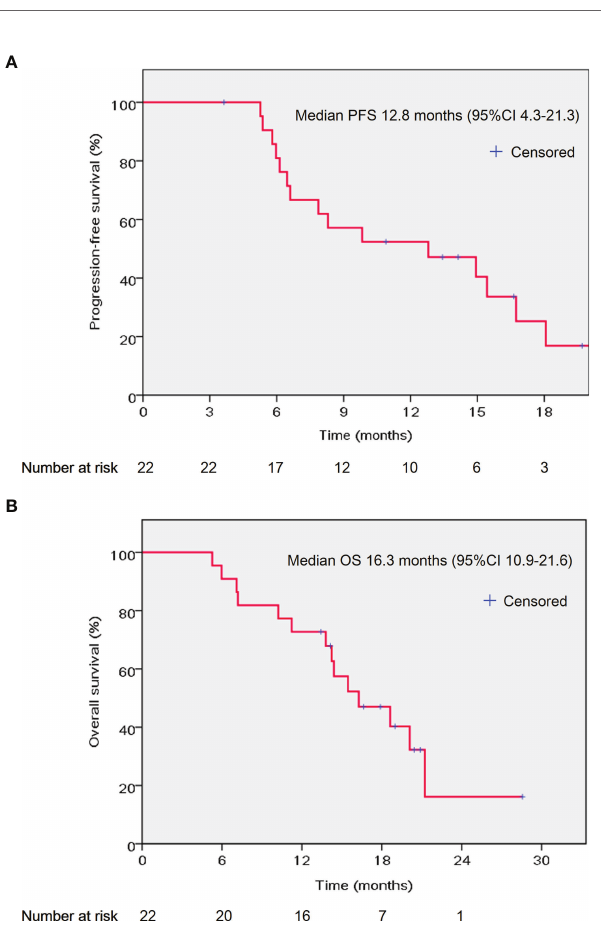
FIGURE 1 | Kaplan – Meier curves of PFS (A) and OS (B) in the studied population. PFS, progression-free survival; OS, overall survival; CI: con fi dence